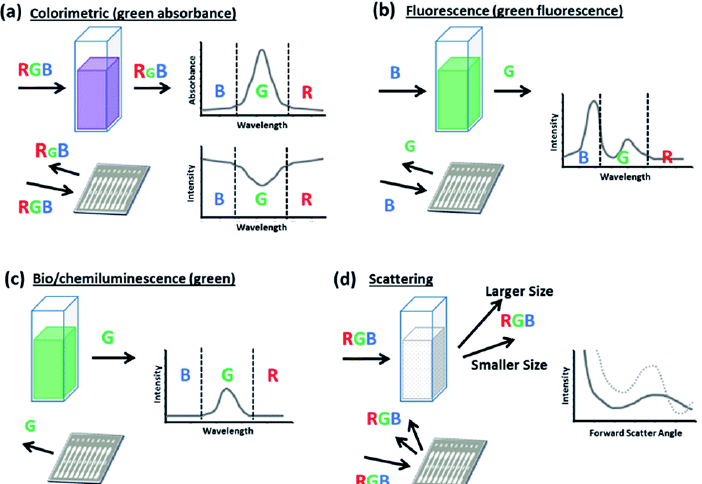
Figure 3. Typical optical detection for both light transmitted through liquid sample platforms (i.e., cuvette, well plate) and light reflected from solid sample platforms (i.e., test strip, cassette) using ( a ) colorimetric assays, ( b ) fluorescence-based assays, ( c ) bio- and chemiluminescence assays, and ( d ) scattering-based assays. Reproduced with the permission of [106]. Copyright 2016 Published by The Royal Society of Chemistry.